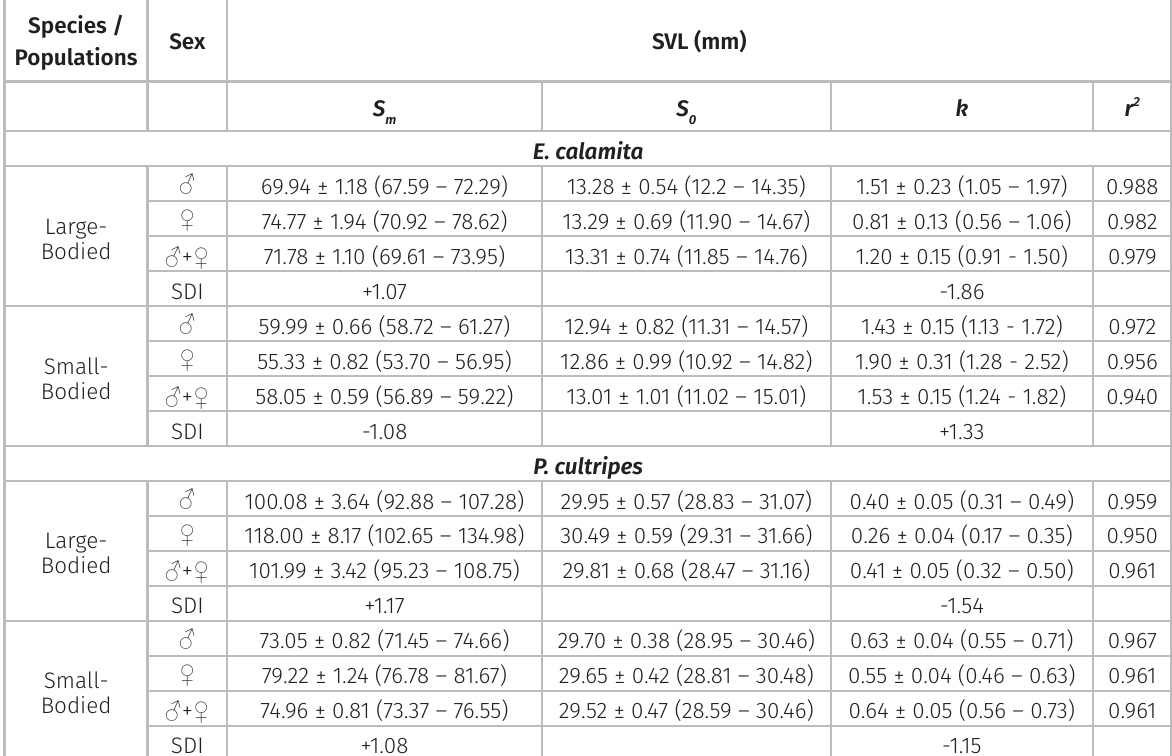
Table IV. Estimated parameters from von Bertalanffy’s equation, for body growth (SVL) of Epidalea calamita and Pelobates cultripes . S = average maximal body size, S = body size at metamorphosis (see text for details). k = m 0 growth coefficient, defining the shape of the growth curve, r 2 = model fit. SDI: sexual dimorphism index. All values are means ± 1 SE (CI